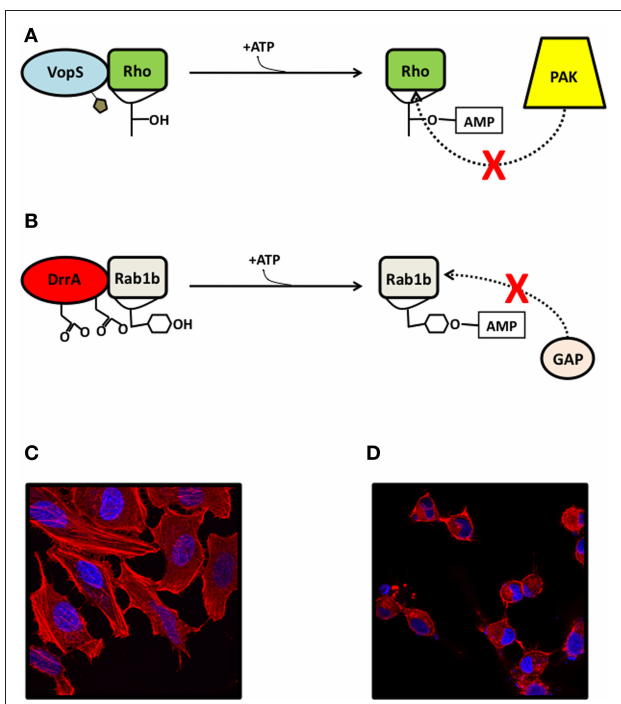
FIGure 1 | AMPylation in pathogenicity. (A) The Fic effector AMPylators VopS (shown) and IbpA are secreted into eukaryotic cells and modify a threonine or tyrosine residue on the Switch 1 loop of Rho family GTPases, sterically blocking their association with downstream substrates like PAK and rhotekin. (B) The adenylyl transferase effector AMPylator DrrA catalyzes the exchange of GDP for GTP in the GTPase Rab1b through its GEF domain (not shown) and AMPylates a tyrosine in the Switch 2 loop, preventing its association with GAPs. (C, D) HeLa cells transfected with mock vector (C) or with VopS (D) , visualized with confocal microscopy for rhodamine phalloidin stain (actin, red) and Hoechst stain (DNA,